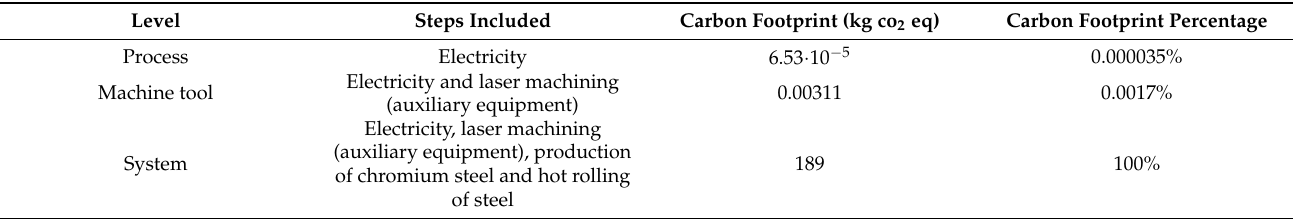
Figure 4. Allocation and percentages of carbon footprint per step in laser grooving, showing that the highest percentage of carbon footprint is coming from the production of steel (95%). Table 5. Carbon footprint for laser grooving per level.